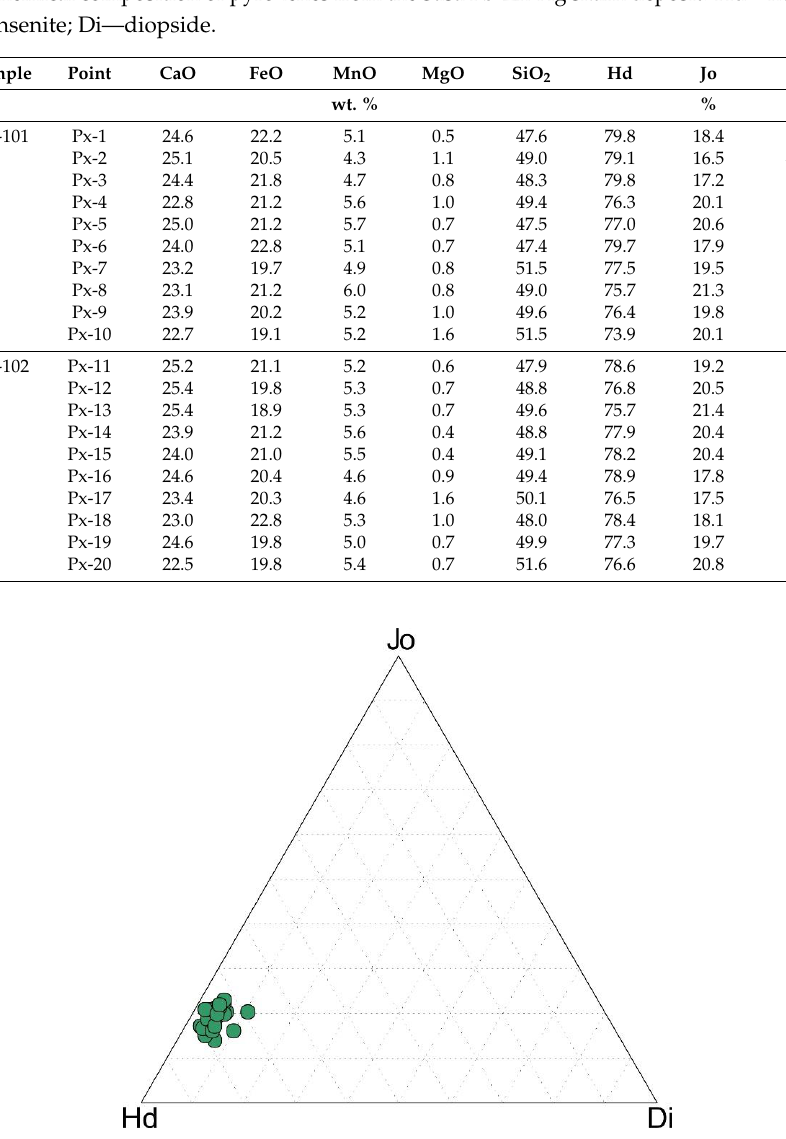
Table 1. Chemical composition of pyroxenes from the Sasa Pb-Zn-Ag skarn deposit. Hd—hedenbergite; Jo—johannsenite; Di—diopside.